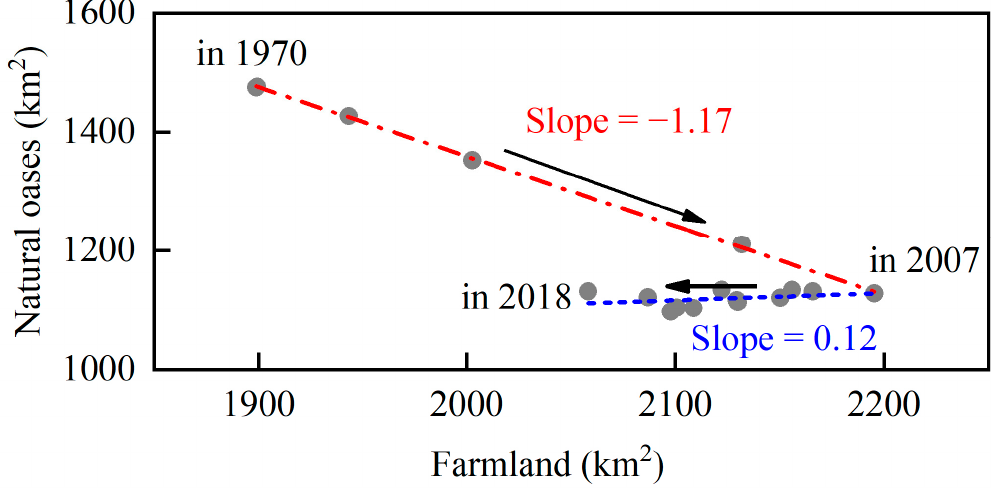
Figure 7. Relationship between the farmland area and the natural oasis